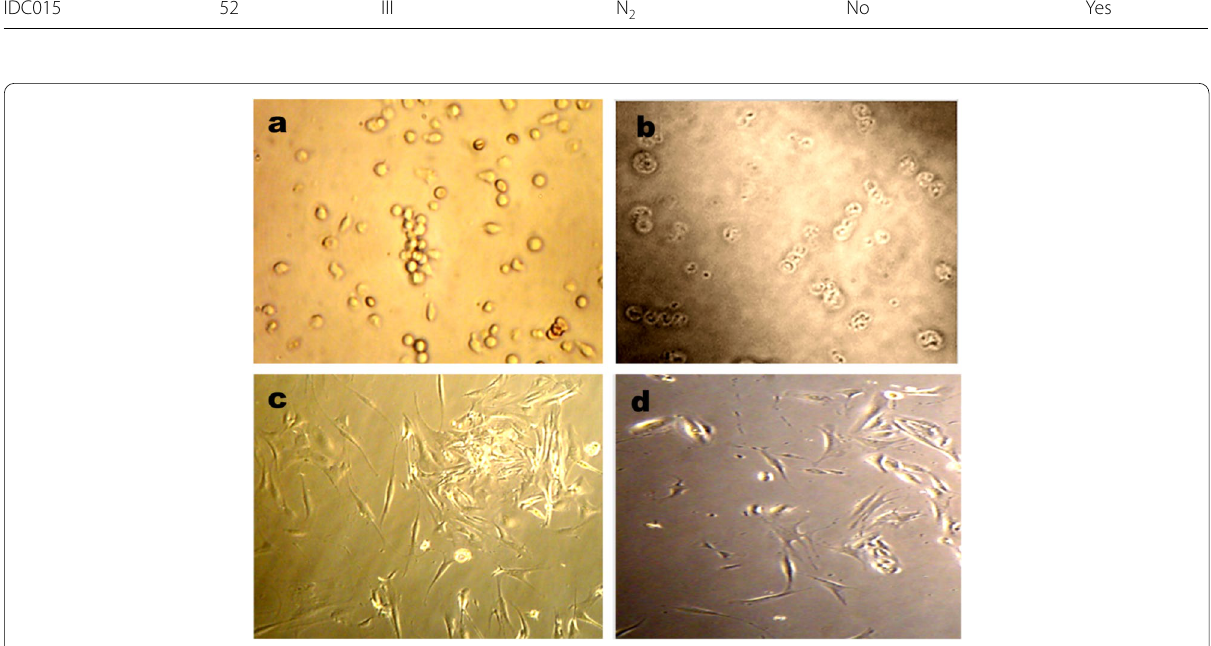
Fig. 1 Breast cells obtained from the normal breast tissues, primary breast tumors, and MCF-7 cell